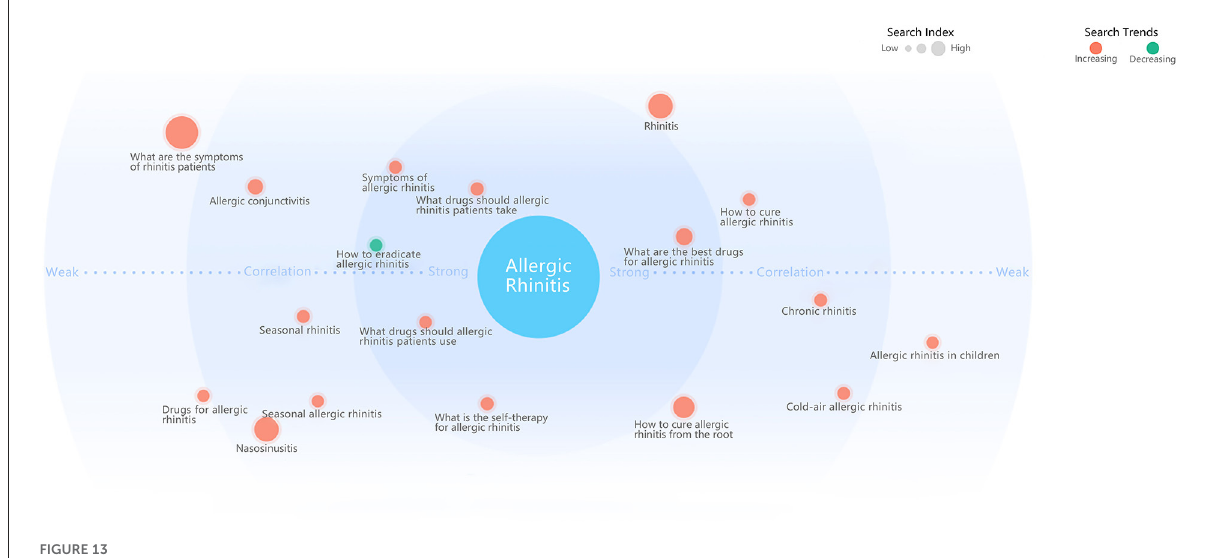
FIGURE13 Demand graph of